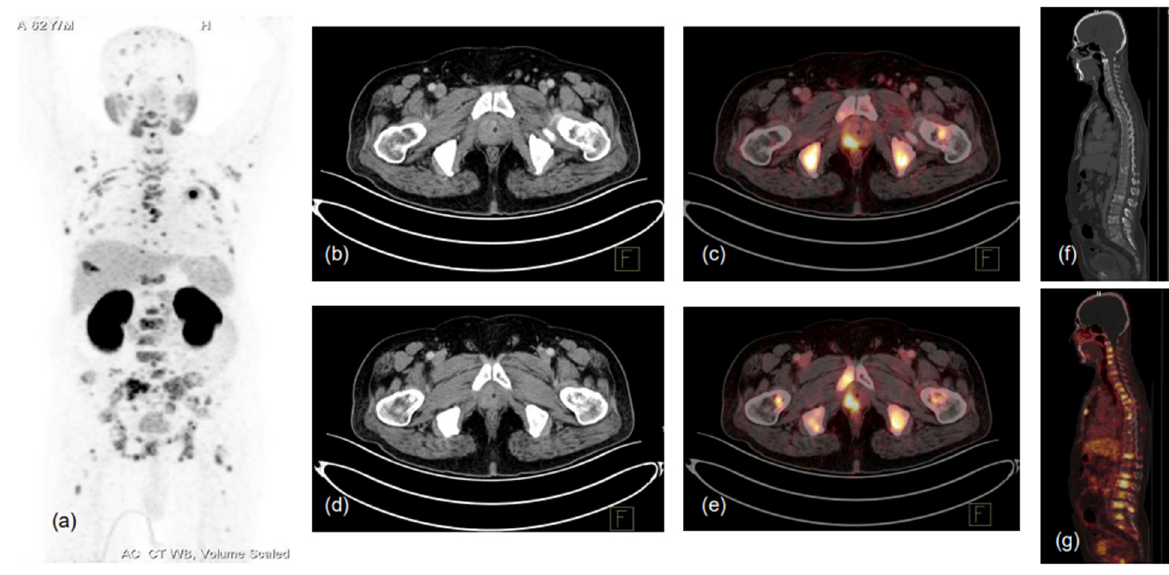
Figure 2. 62-year-old male, presented with lower urinary tract symptoms (LUTS) and